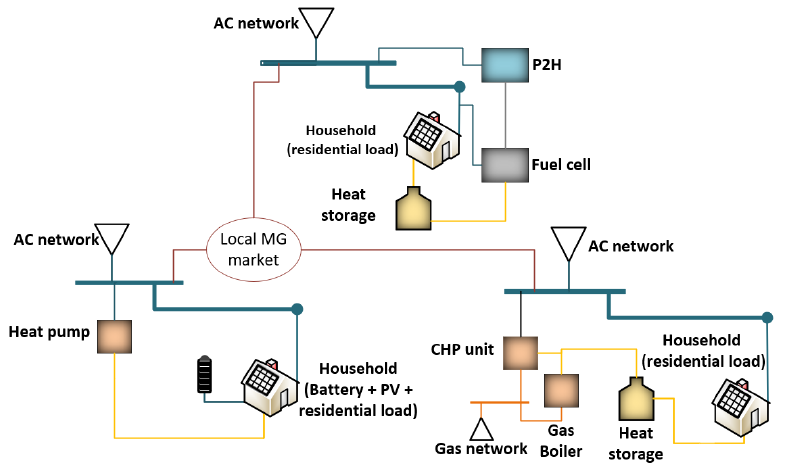
Figure 1. The layout of the